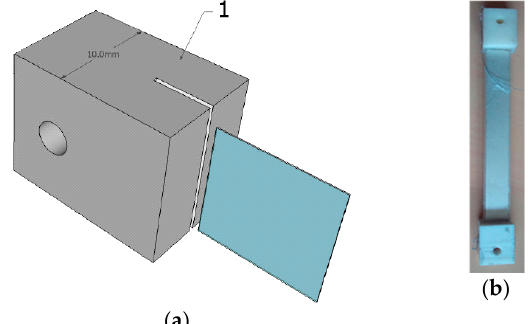
Figure 1. ( a ) Schematic drawing of the clamp for polymer film. Part 1 is 3D-printed in which the polymer film is glued; ( b ) Picture of a PVDF capacitor sample ready to use.